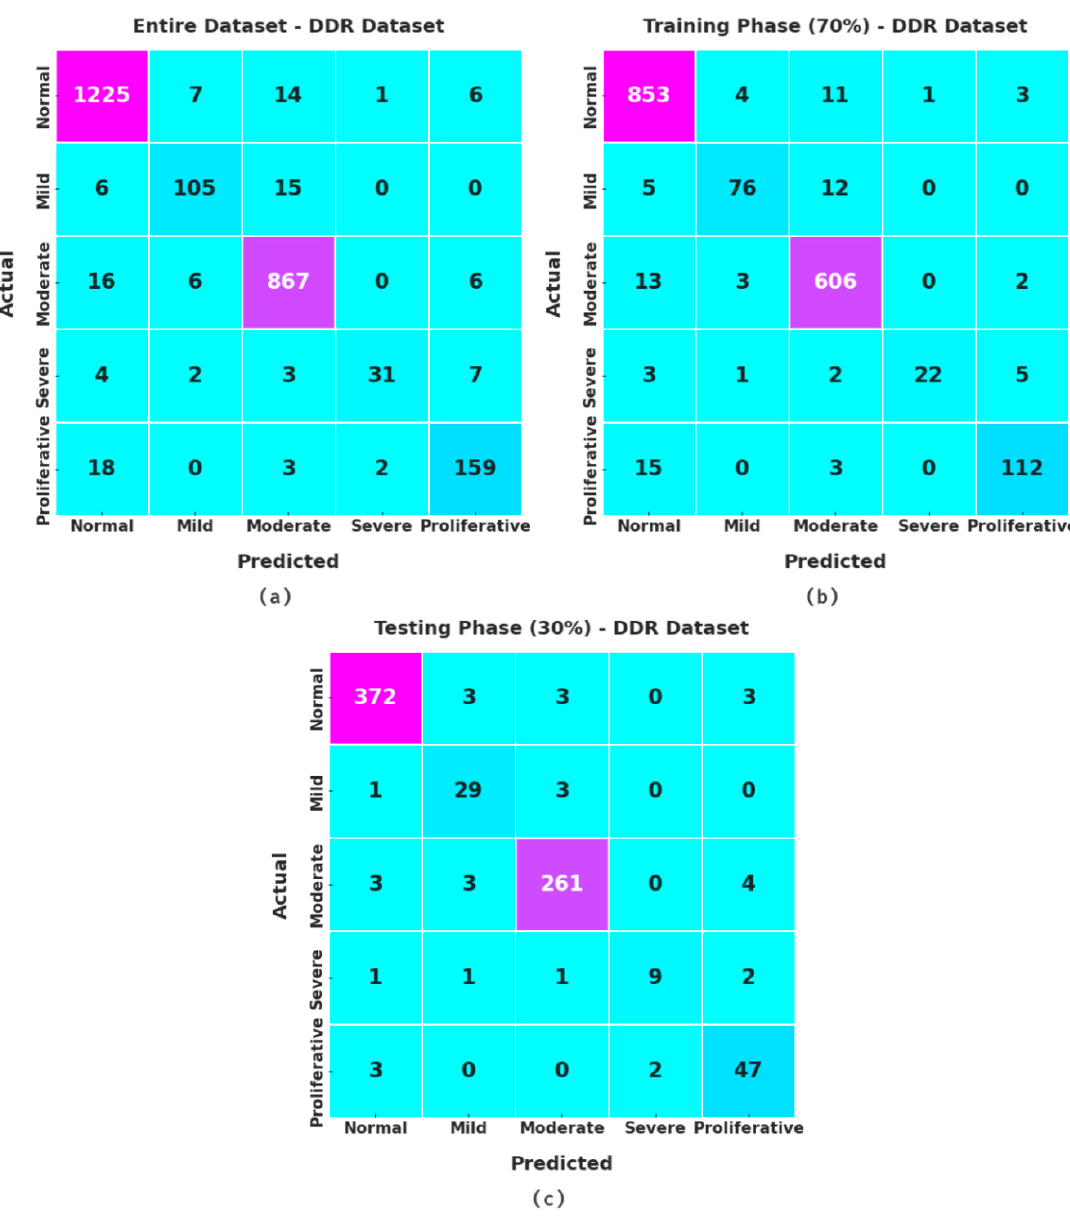
Figure 8. Confusion matrices of the XAITO-DRGC approach under the DDR dataset ( a ) entire dataset, ( b ) 70% of TR data, and ( c ) 30% of TS data.